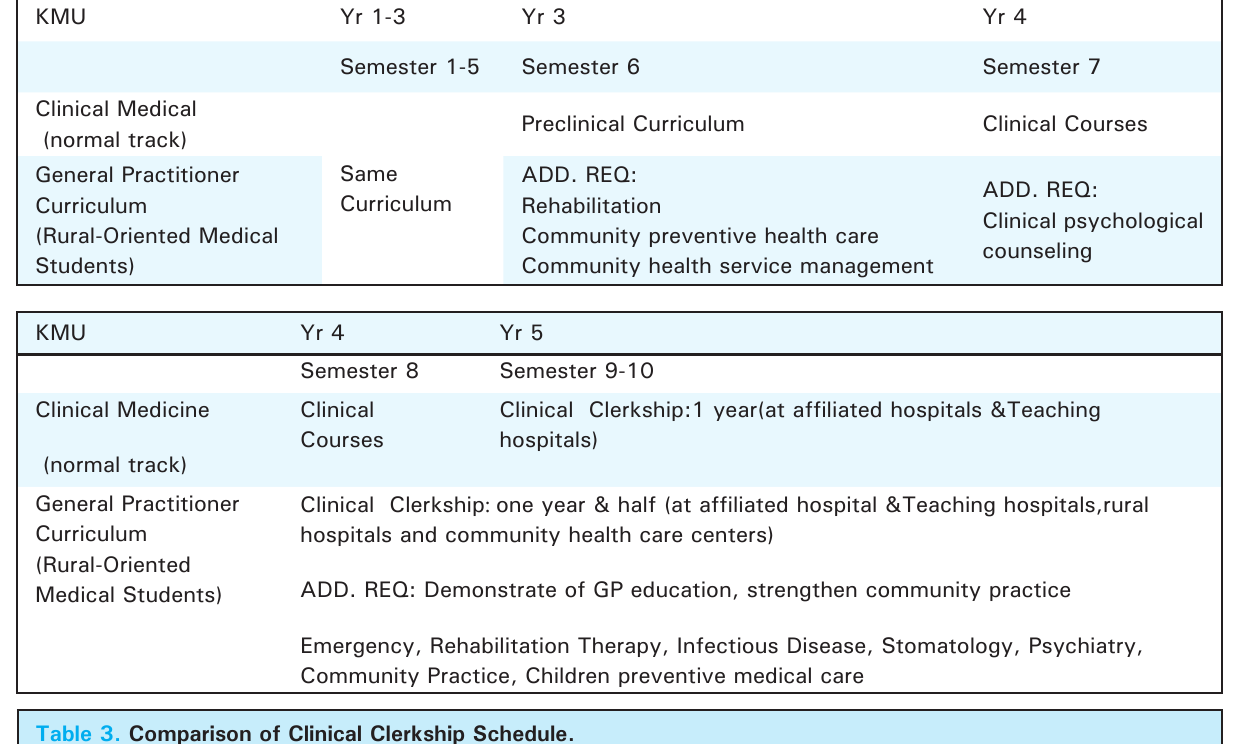
Table 3. Comparison of Clinical Clerkship